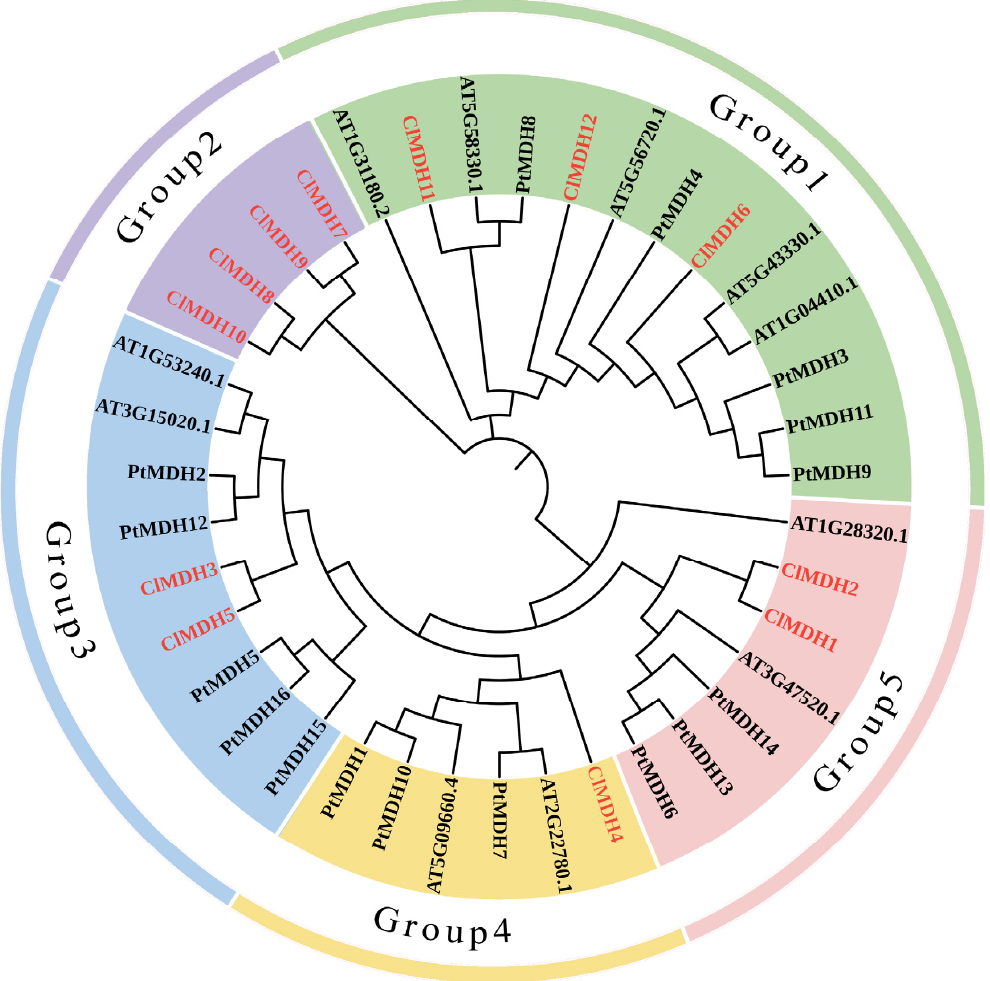
Figure 1. An unrooted neighbor-joining (NJ) phylogenetic tree based on MDH protein sequence alignment between Arabidopsis , Populus , and Cunninghamia with 1000 bootstraps. All the MDH members were divided into 5 groups and presented in different colors. The red letter represented ClMDH sequences and the black letter represented PtMDH and AtMDH sequences.